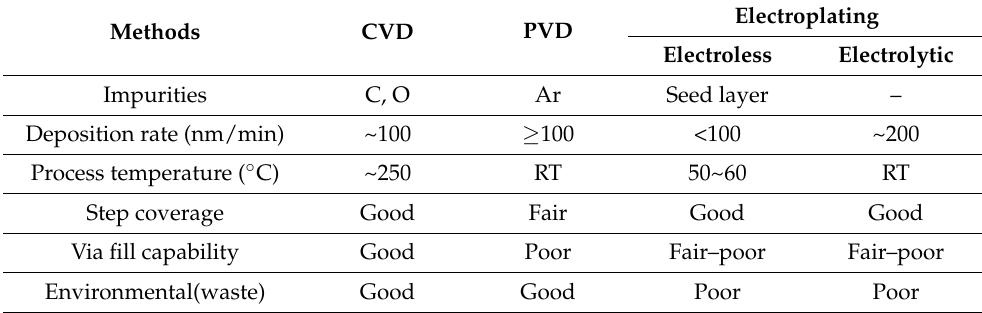
Table 6. Comparison of copper film growth in various